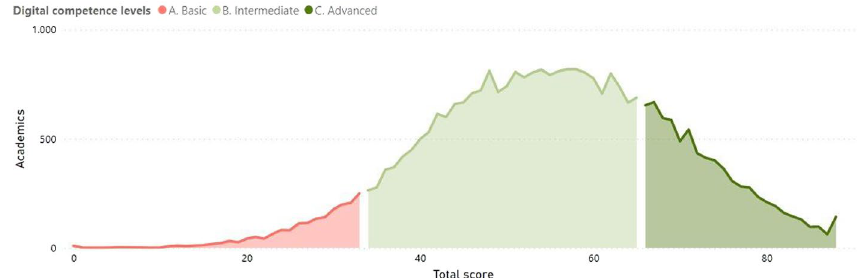
Fig. 2 Digital-competence levels according to its score